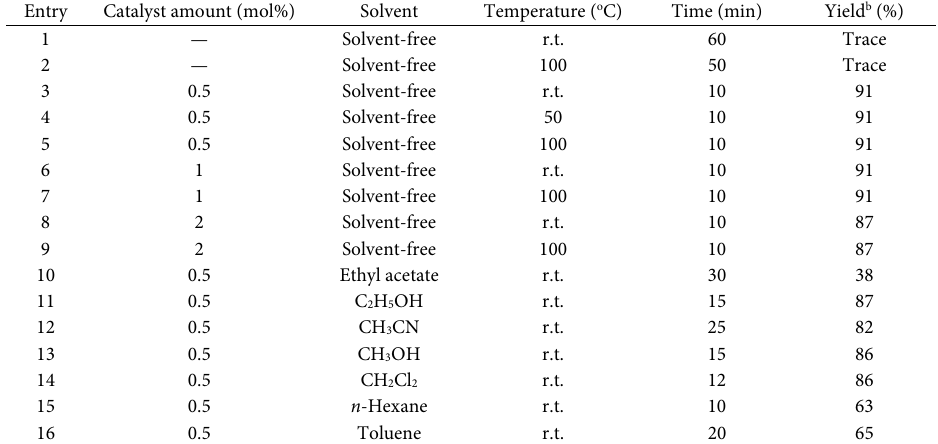
Table 2. Synthesis of 3,4-dihydropyrano[ c ]chromenes using {[2,2'-BPyH][C(CN) 3 ] 2 }. a